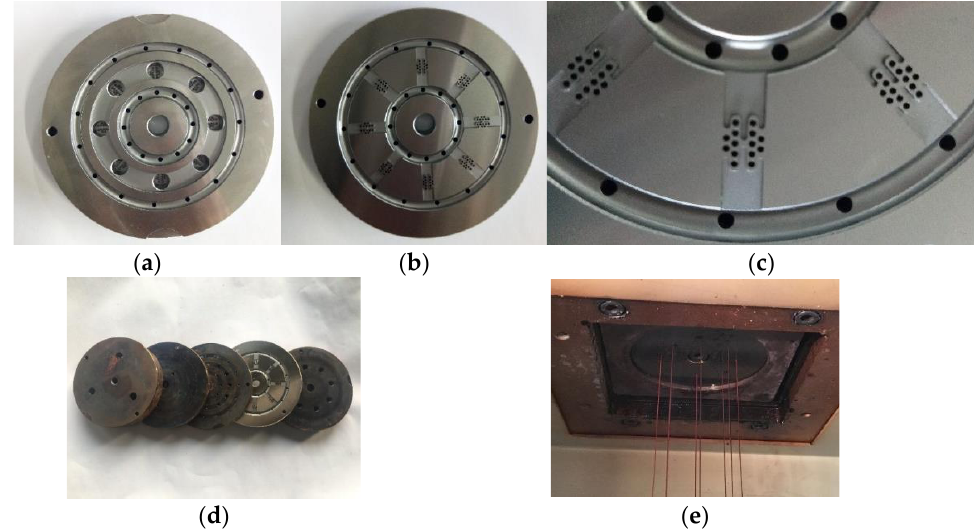
Figure 6. The spinning pack and equipment for the fiber with a “fishbone” cross-section. ( a ) Top view of the distribution board; ( b ) bottom view of the distribution board; ( c ) partial view of the distribution board; ( d ) the spinning pack assembly; ( e ) the spinning equipment.